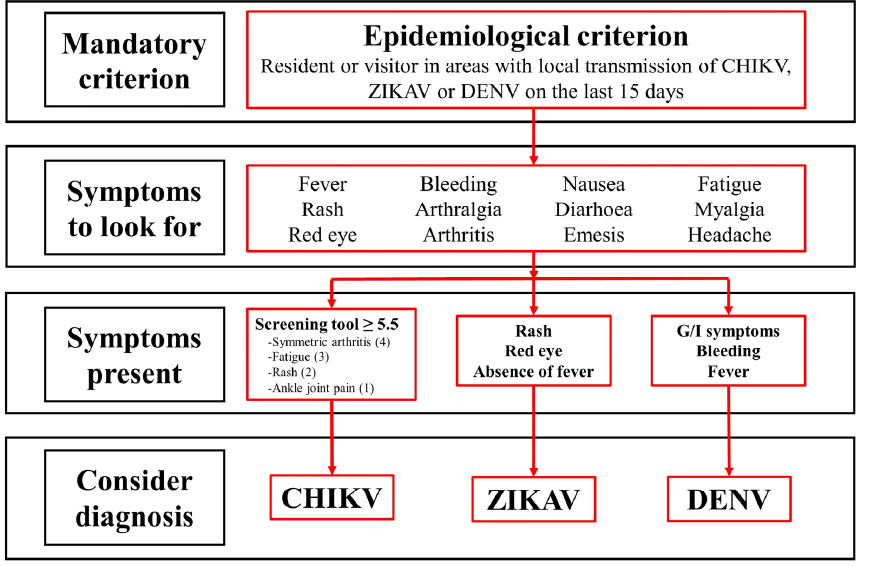
Figure 7. Proposed algorithm for clinical approach of CHIKV, ZIKAV and DENV. DENV: Dengue virus; CHIKV: Chikungunya virus; ZIKAV: Zika virus.